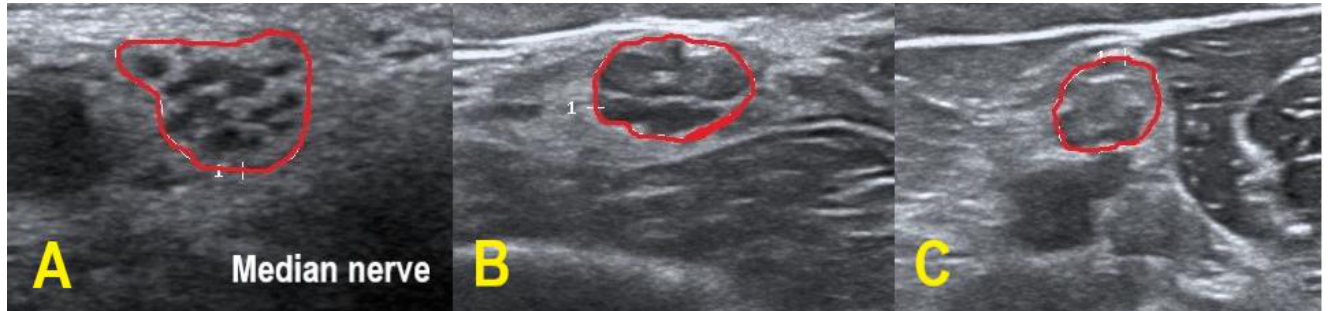
Figure 3. HRUS of the right upper arm median nerve. POEMS syndrome patient #1 demonstrated hypoechoic fascicles and hyperechoic intraneural connective tissue (( A ) within red border). In CIDP patient #6, HRUS depicted hypoechoic next to hyperechoic fascicles (( B ) within red border), whereas HRUS in CIDP patient #9 showed hyperechoic fascicles (( C ) within red border).